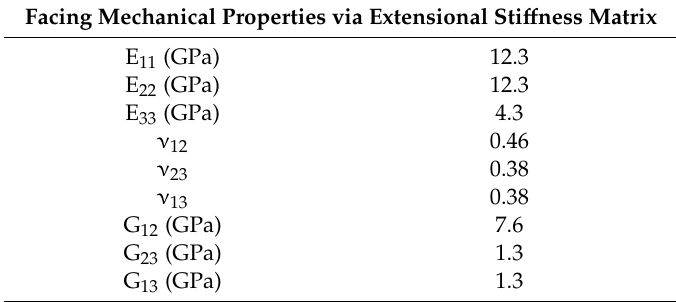
Table 4. Properties of the fiber-reinforced composite as a quasi-laminate. Facing Mechanical Properties via Extensional Sti ff ness